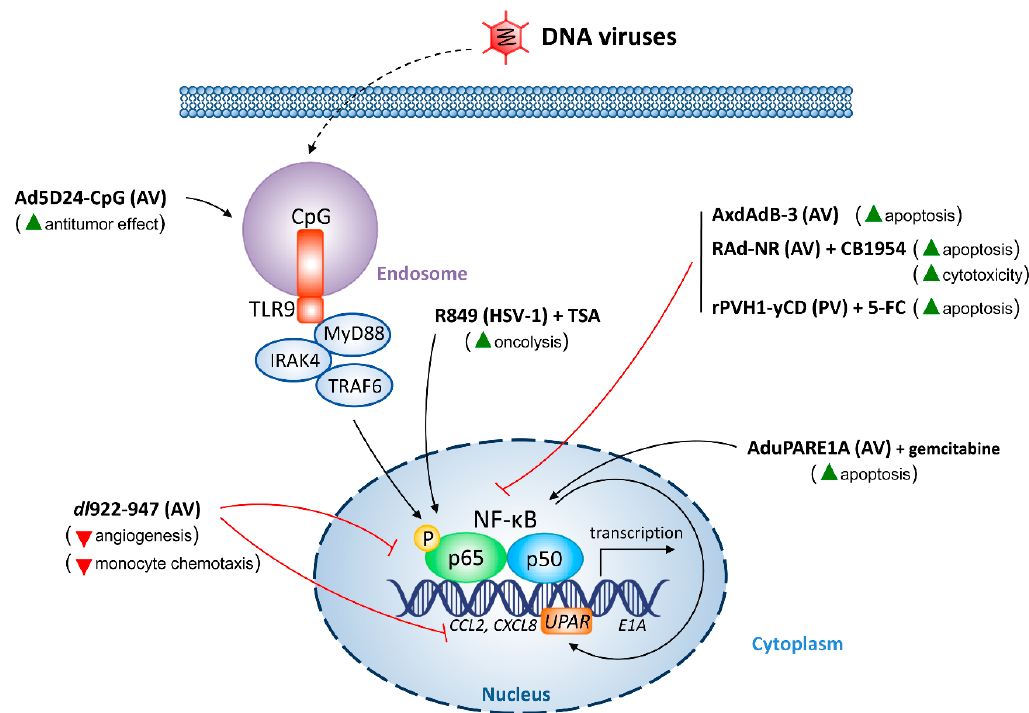
Figure 2. The impact of oncolytic DNA viruses on nuclear factor (NF)- κ B signaling. Activation of NF- κ B signaling components is indicated by pointing black arrows. Inhibition of NF- κ B is indicated by red blunt arrows. The outcomes of NF- κ B modulation are shown in the brackets. Induction is indicated by green triangles, whereas inhibition—by inverted red triangles. 5-FC, 5-fluorocytosine; AV, adenovirus; CCL2 , chemokine (C-C motif) ligand 2 gene; CpG, cytosine:guanine islands; CXCL8 , C-X-C motif chemokine ligand 8 gene; HSV-1, herpes simplex virus type 1; IRAK4, interleukin-1 receptor–associated kinase 4; MyD88, myeloid differentiation primary response protein 88; PV, parvovirus; TLR9, Toll-like receptor 9; TRAF6, tumor necrosis factor receptor-associated factor 6; TSA, trichostatin A; UPAR , urokinase-type plasminogen activator receptor promoter.